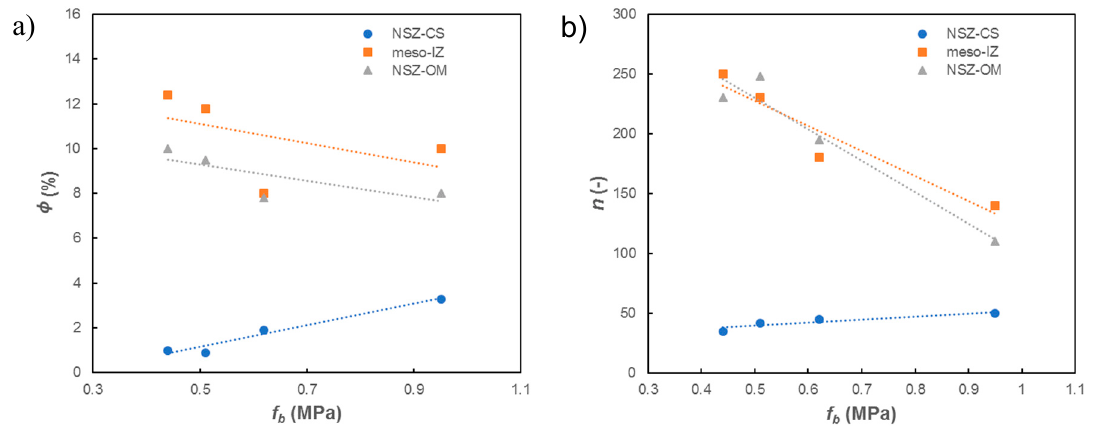
Figure 12. Relation of the pull-off adhesion f b of the overlay with the substrate with regard to fraction of pores Φ ( a ) and number of pores ( b ): IZ—interphase zone, NSZ-CS—the near surface zone of the concrete substrate, NSZ-OM—the near surface zone of the mortar overlay (based on the results presented in Reference [50]).